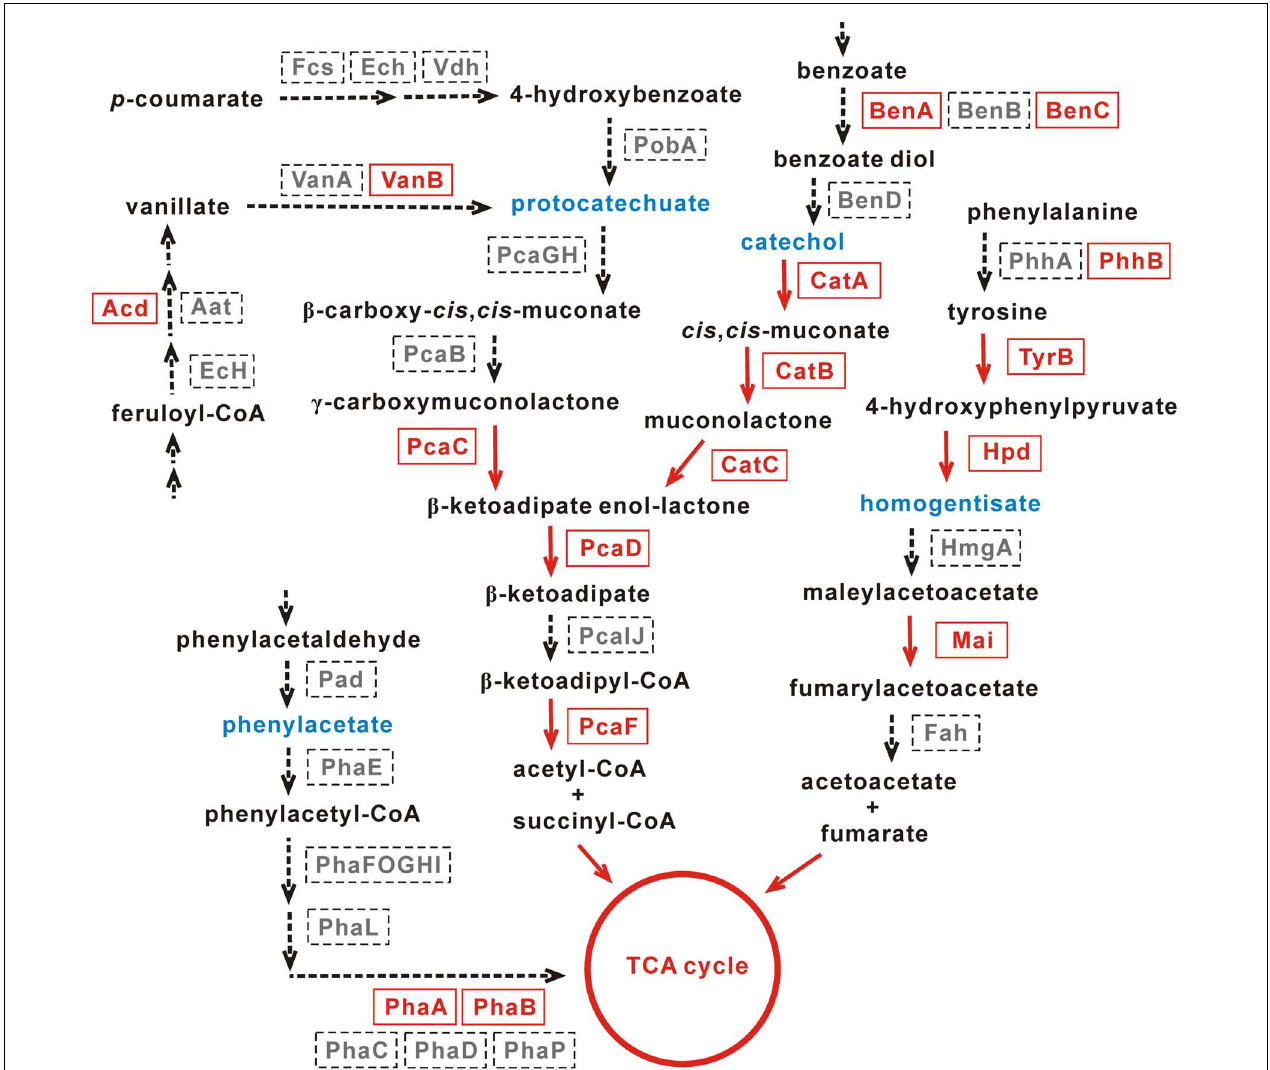
FIGURE 5 | Pathways for the degradation of aromatic compounds in Achromobacter sp. HZ01. The enzymes present and absent in strain HZ01 are shown in red fonts and gray fonts, respectively. The red arrows indicate that strain HZ01 contains corresponding metabolic steps. The dotted arrows show the lacking steps in strain HZ01. Blue fonts represent the key intermediate products. Not all the upper-stream steps are shown in the